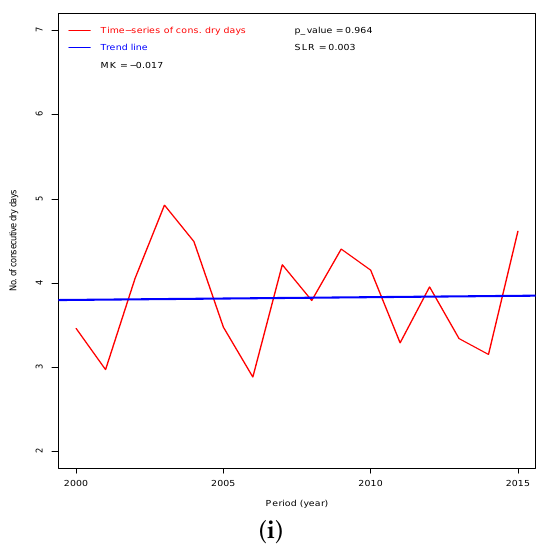
Figure 7. The figure is for consecutive dry days. For each station, an average of consecutive dry days (days with no rainfall) is computed to give the trend for different stations. ( a ) Entebbe; ( b ) Jinja; ( c ) Kamenyamigo; ( d ) Kituza; ( e ) Makerere; ( f ) Namulonge; ( g ) Ntusi; ( h ) Tororo; ( i ) An average over the number of consecutive dry days over the study area.